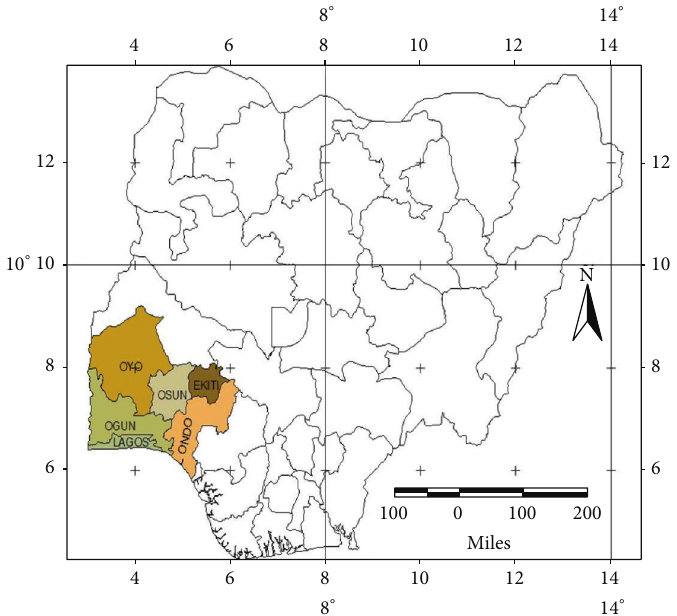
Figure 1: The Nigerian map showing the southwestern